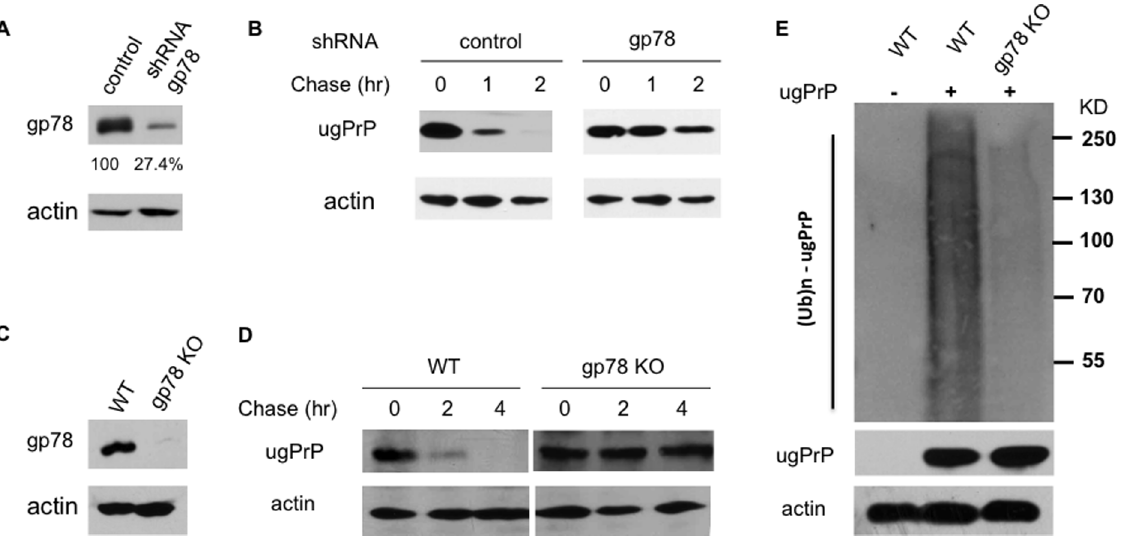
Figure 3. gp78 promotes ugPrP ubiquitylation and degradation. ( A ) gp78 knockdown efficiency in HEK293 cells. HEK293 cells were transfected with the gp78 shRNA or control plasmid. Cell extracts were subjected to immunoblotting analysis to determine the levels of gp78 and actin (loading control). Knockdown efficiency (27.4%) was indicated underneath the panel. ( B ) Effect of gp78 knockdown on ugPrP turnover. Degradation kinetics of ugPrP was assessed in gp78 knockdown or control HEK293 cells. Actin is shown as a loading control. Protein stability assay via cycloheximide chase was done as described in Figure 1. ( C ) gp78 deficient MEFs. gp78 expression was evaluated by western blotting in gp78 2 / 2 and control MEFs. ( D ) ugPrP degradation is impaired in gp78 2 / 2 MEFs. gp78 2 / 2 and control MEFs were transfected with the plasmid encoding ugPrP. ugPrP turnover was evaluated by cycloheximde chase as in Figure 1. ( E ) gp78 is important for ugPrP ubiquitylation. gp78 2 / 2 and control MEFs expressing ugPrP were treated with MG132 for 6 h and then lysed, and later subjected to immunoprecipitation with PrP antibody. The immunoprecipitates were analyzed by western blotting with Ub antibody and 3F4 for ugPrP (upper panels). The amount of actin in cell extracts was assessed by immunoblotting with actin antibody (bottom panel).